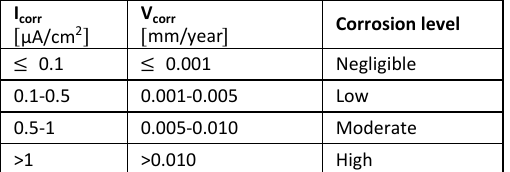
Table 1. Ranges of corrosion and penetration rates with the corresponding corrosion levels